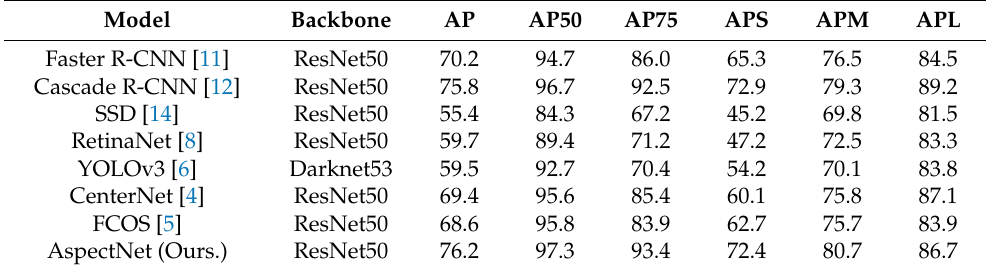
Table 5. Comparison of results with other methods on the BCTSDB val dataset.